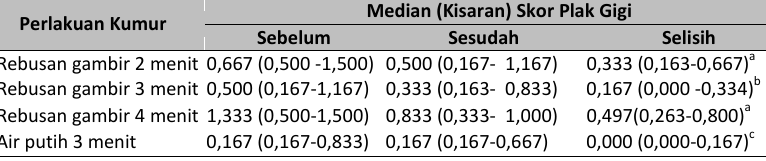
Tabel 1. Skor plak gigi sebelum, sesudah dan selisihnya pada berbagai perlakuan